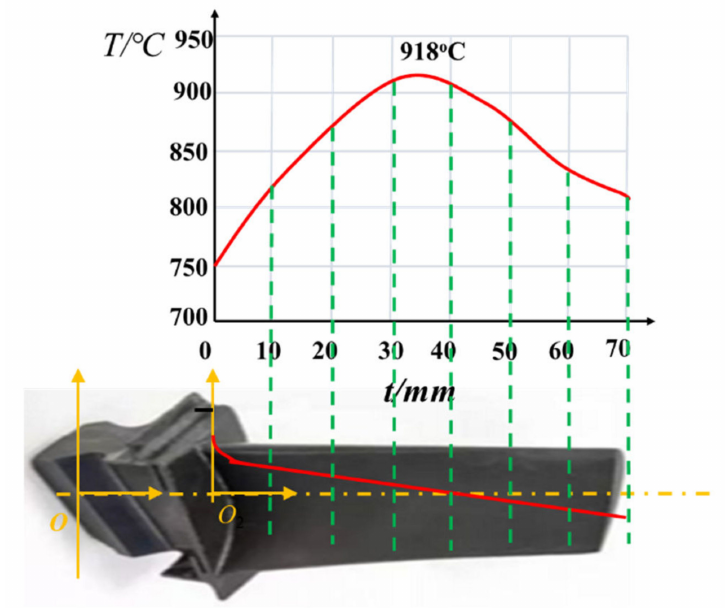
Figure 5. Piecewise interpolation of temperature distribution along the blade [31].